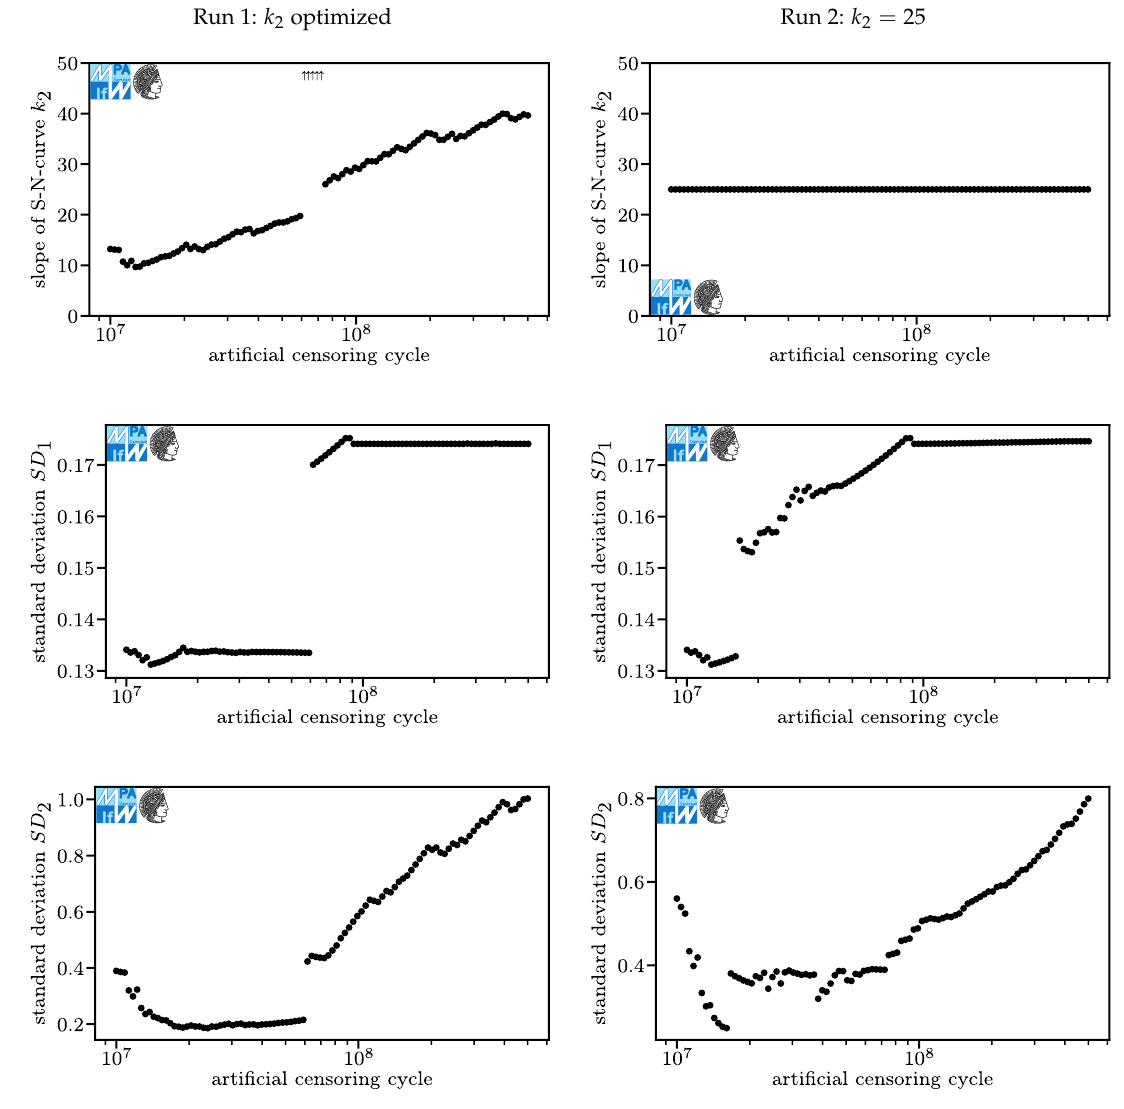
Figure 7. Results of optimization processes for Run 1 ( left ) and Run 2 ( right )